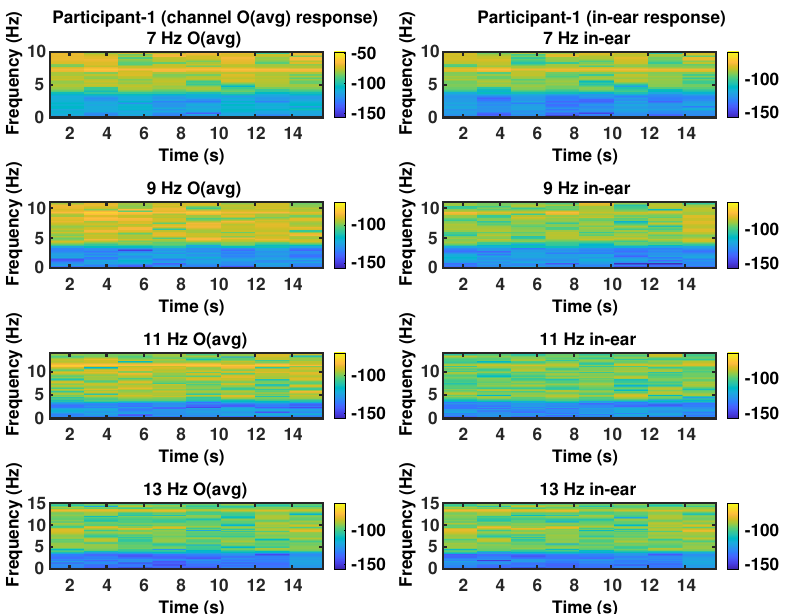
Figure 7. Spectrogram of participant 1 from occipital and in-ear